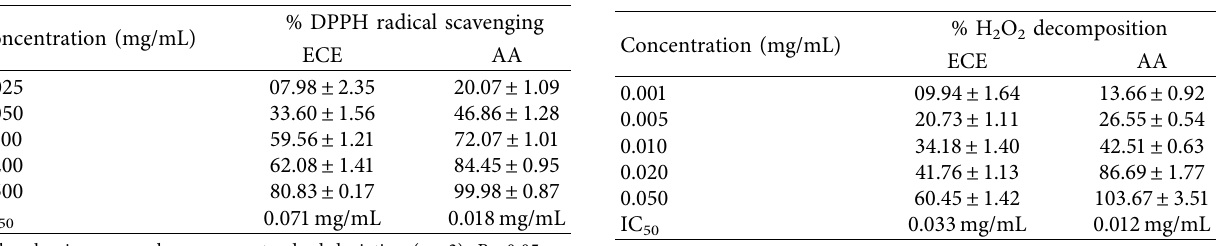
Figure 1: Ferric reducing the activity of E. californicum extract (ECE) and ascorbic acid (AA). Each data point is expressed as mean standard deviation ( n 3); P 0 . 05. (cid:31) ± < Table 2: DPPH radical scavenging activity of E. californicum ex- Table 4: Hydrogen peroxide decomposition activity of tract (ECE) and ascorbic acid (AA). E. californicum extract (ECE) and ascorbic acid